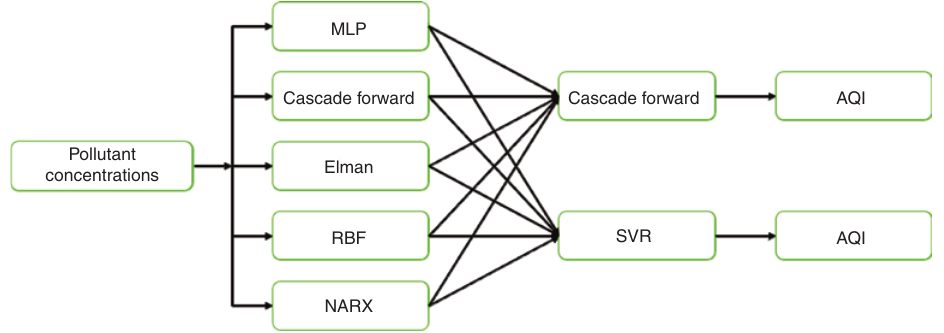
Figure 1: Cascade Forward and SVR Ensemble of Neural Network